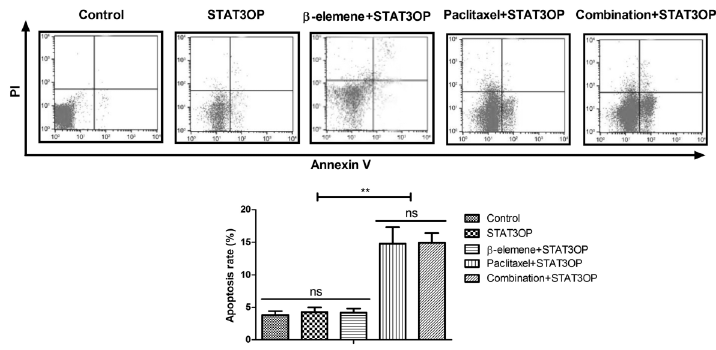
Figure 7 . Effects of STAT3 overexpression (STAT3OP) on b -elemene + paclitaxel-regulated apoptosis of SKOV3 cells. Data are reported as means ± SD. **P o 0.01 (ANOVA followed by Tukey ’ s multiple comparison post hoc test). ns: not signi fi cant.